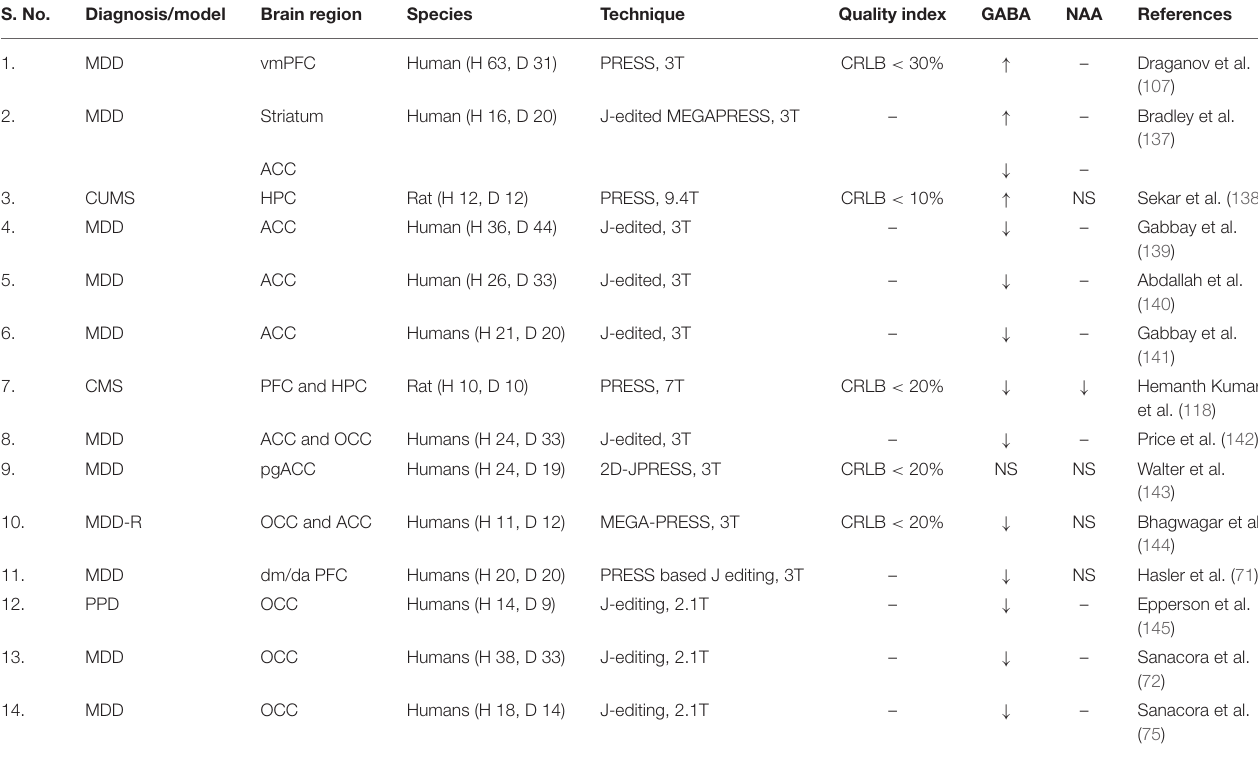
TABLE 2 | Brain GABA homeostasis in depression. S.